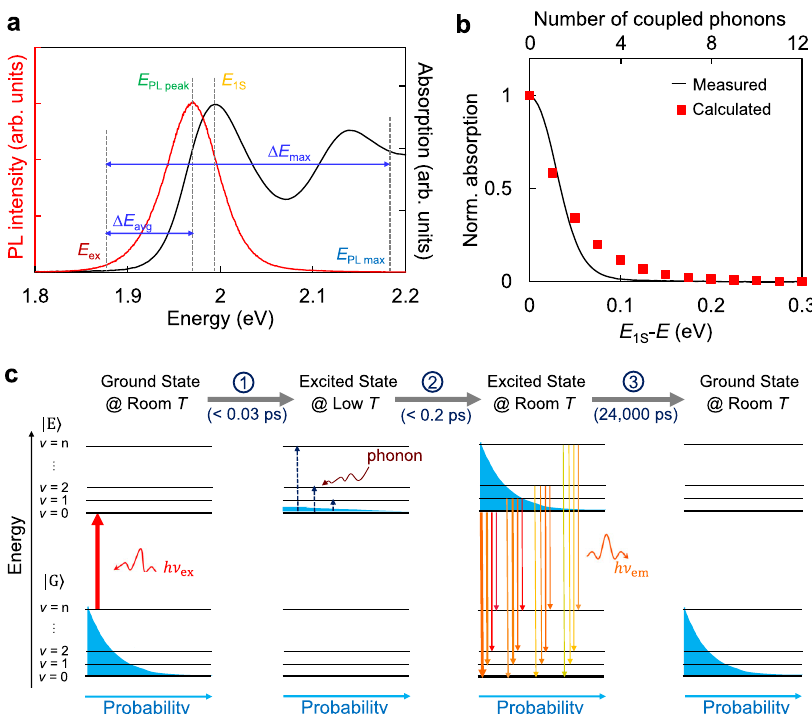
Fig. 5 UCPL mechanism of high-quality QDs. a De fi nitions of the average up-conversion energy gain ( Δ E avg ) and the maximum energy gain ( Δ E max ) for UCPL. E ex , E PL peak , E 1S , and E PL max are the energy of the excitation light, the photoluminescence peak, the 1 st excitonic absorption peak and the maximum detected photoluminescence. The above energies are marked on the absorption (black) and photoluminescence (red) spectra. b Measured (black line) and calculated (red squares) absorption spectra normalized at the 1st excitonic absorption peak. The spectrum is calculated according to Eq. S33 in the Supplementary Information. E 1S – E denotes the energy difference of the 1st excitonic absorption peak and the excitation photons. c Schematics of the UCPL mechanism. Shown is one set of electron – phonon coupled states with a speci fi c phonon mode. v is the quantum number of phonon. |G ⟩ and |E ⟩ are ground and excited states respectively. hv ex and hv em denote excitation and emission lights. Inter-band (intra-band) transitions are marked as solid (dashed)